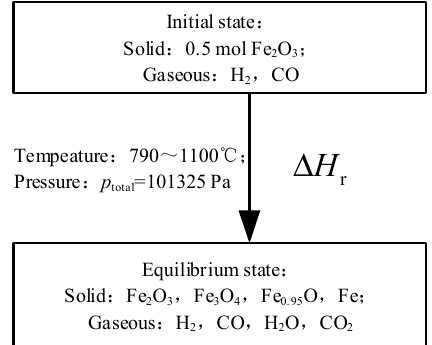
Figure 2. The initial and equilibrium state of the system of the reducer.